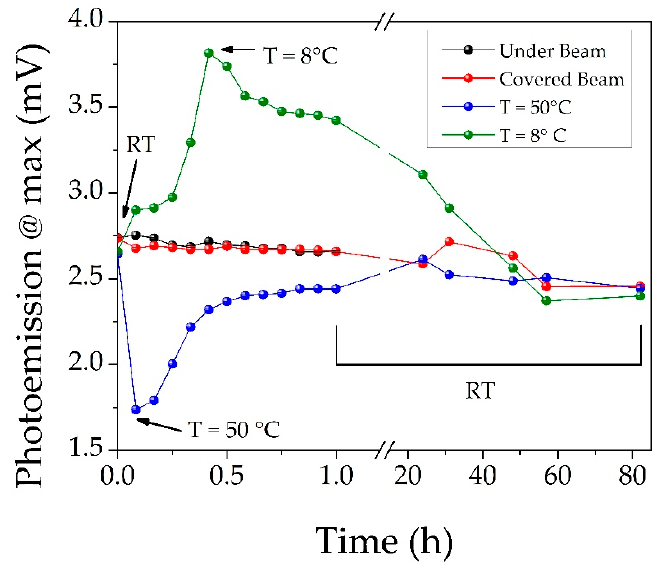
Figure 2. Stability of the AgNCs solution under different conditions: continuous lighting (black line, only for the first hour), covering the light beam (red curve), warming up process (blue line), cooling down treatment (green curve). The lines are only guides for the eye connecting the experimental points. The errors are included in the points, but are small and not visible on this scale.